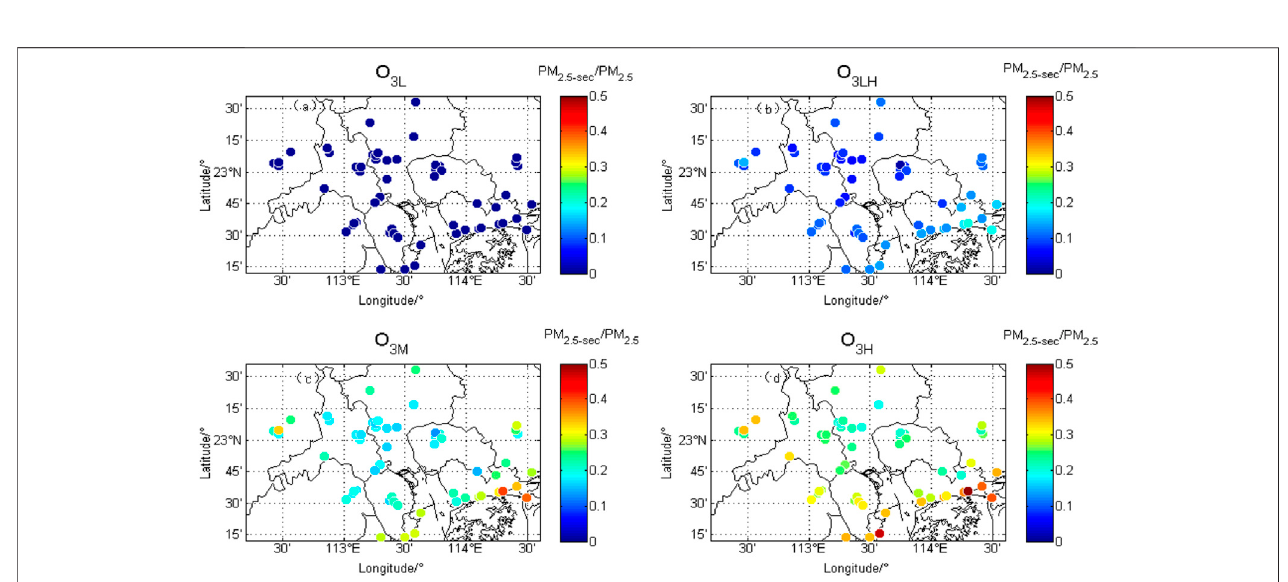
FIGURE 10 | Variations of the ratios in PM 2.5-sec /PM 2.5 under different photochemical backgrounds.